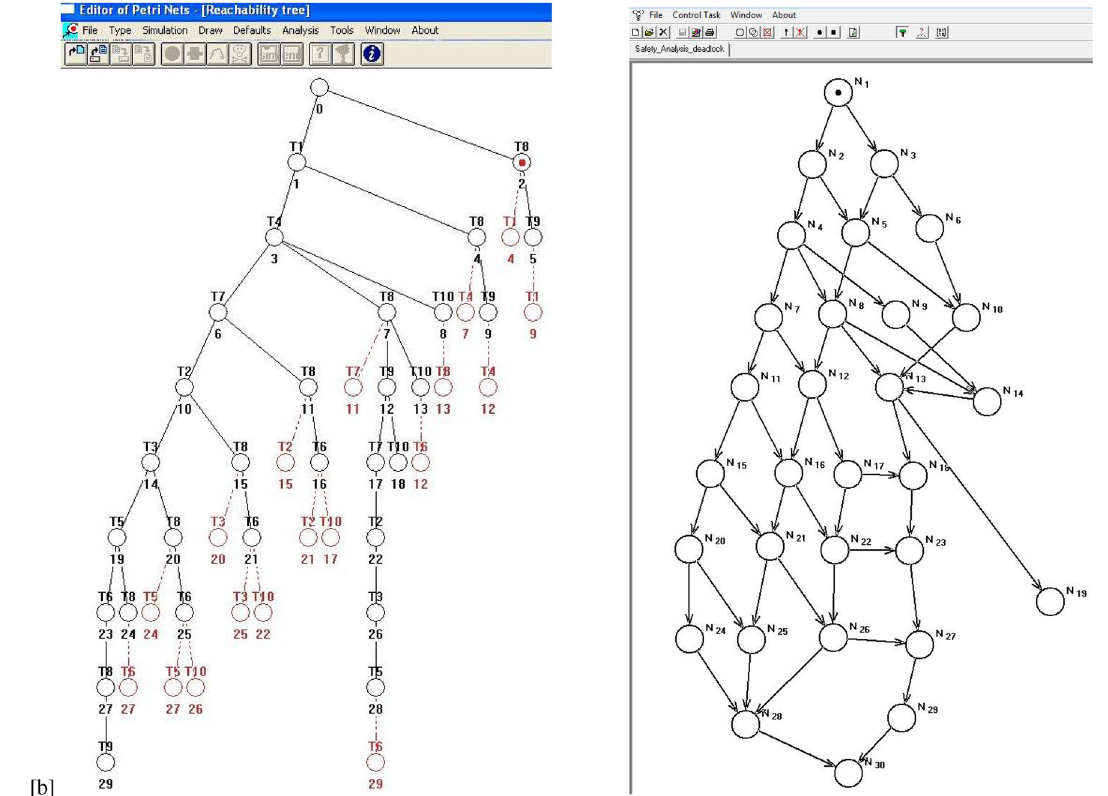
Fig. 7 The RT of the recovered system (left) and the corresponding RG (right) (i.e.,originalsystemplussupervisor)and s x 0 = ( x T is its initial state.